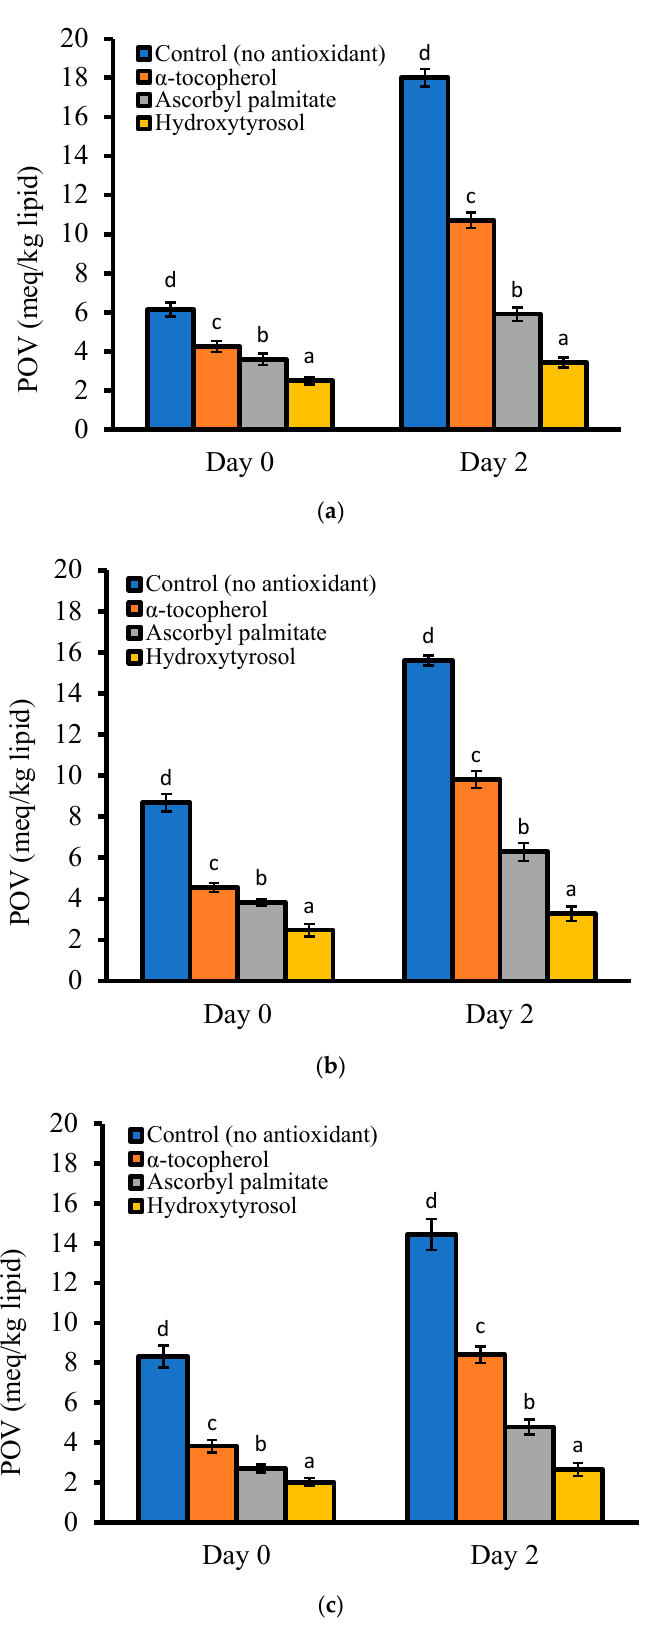
Figure 3. The peroxide values (POV) (meq/kg) of oil extracted from ( a ) squid, ( b ) hoki and ( c ) prawn after deep frying and refrigerated storage. Values are expressed as mean ± standard deviation ( n = 3). Bars not sharing a common letter are significantly different ( p < 0.05) within each